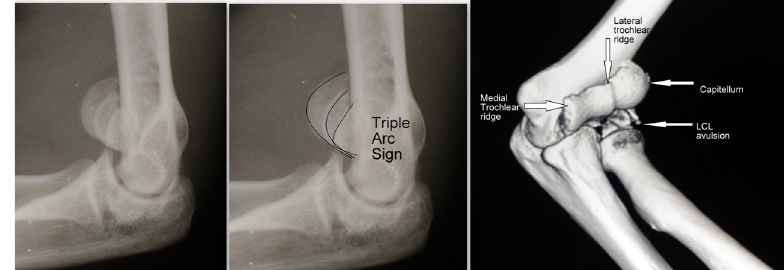
Figure 9. X-rays showing Triple Arc Sign.